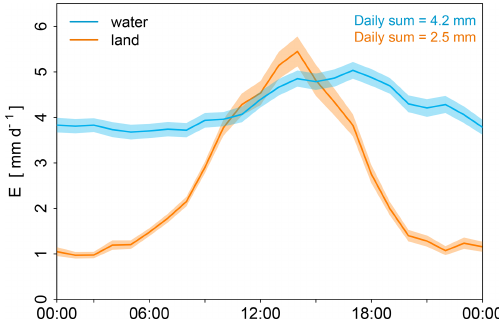
Figure 8. Comparison of the average diurnal cycle of open wa- ter evaporation (blue) and terrestrial evaporation (orange) observed during the summer period 2019 in Stavoren. The shaded area repre- sents the uncertainty band, which is defined as the standard devia- tion divided by the square root of the number of